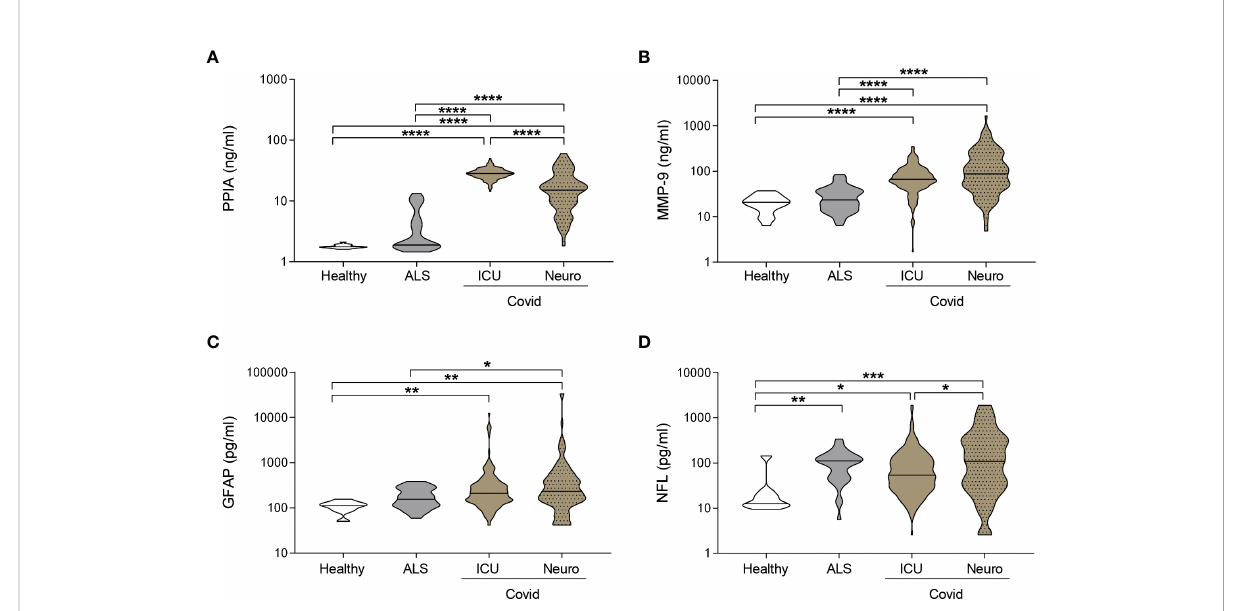
FIGURE 2 Biomarkers comparison between COVID-19 and a neurodegenerative disorder. (A-D) PPIA (A) , MMP-9 (B) , GFAP (C) , and NFL (D) concentrations were measured in plasma samples from ICUCovid patients (ICU n=79), NeuroCovid patients (n=78), ALS patients (PPIA n=50; MMP-9 n=51; GFAP and NFL n=34); and healthy controls (PPIA n=18; MMP-9 n=20; GFAP and NFL n=9). Violin plots indicate median, variability and probability density of biomarker concentrations. (A, B, D) Kruskal-Wallis, p<0.0001; (C) Kruskal-Wallis, p=0.0003. (A-D) *p < 0.05, **p < 0.01, ***p < 0.001, ****p < 0.0001 by Kruskal-Wallis, Dunn ’ s post hoc